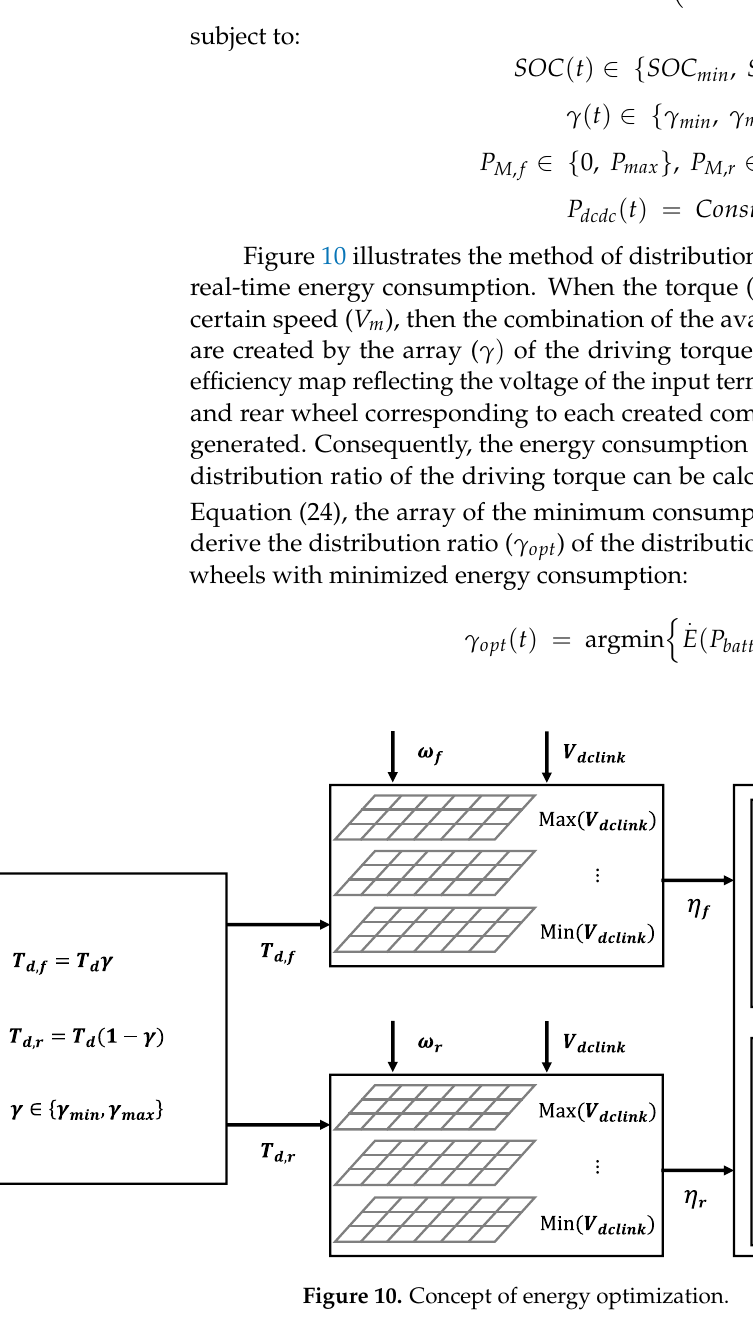
( c ) Figure 11. Optimal front/rear distribution ratios with regard to the speed and desired torque: ( a ) at V dclink = 75 V, ( b ) at V dclink = 90 V ( V norm ), and ( c ) at V dclink = 105 V. The effects of the voltage variation at an input terminal on the optimal distribution of the driving torque to the front and rear wheels were verified at a system input terminal (Front:Rear=0.5:0.5) (Front:Rear=0:1)